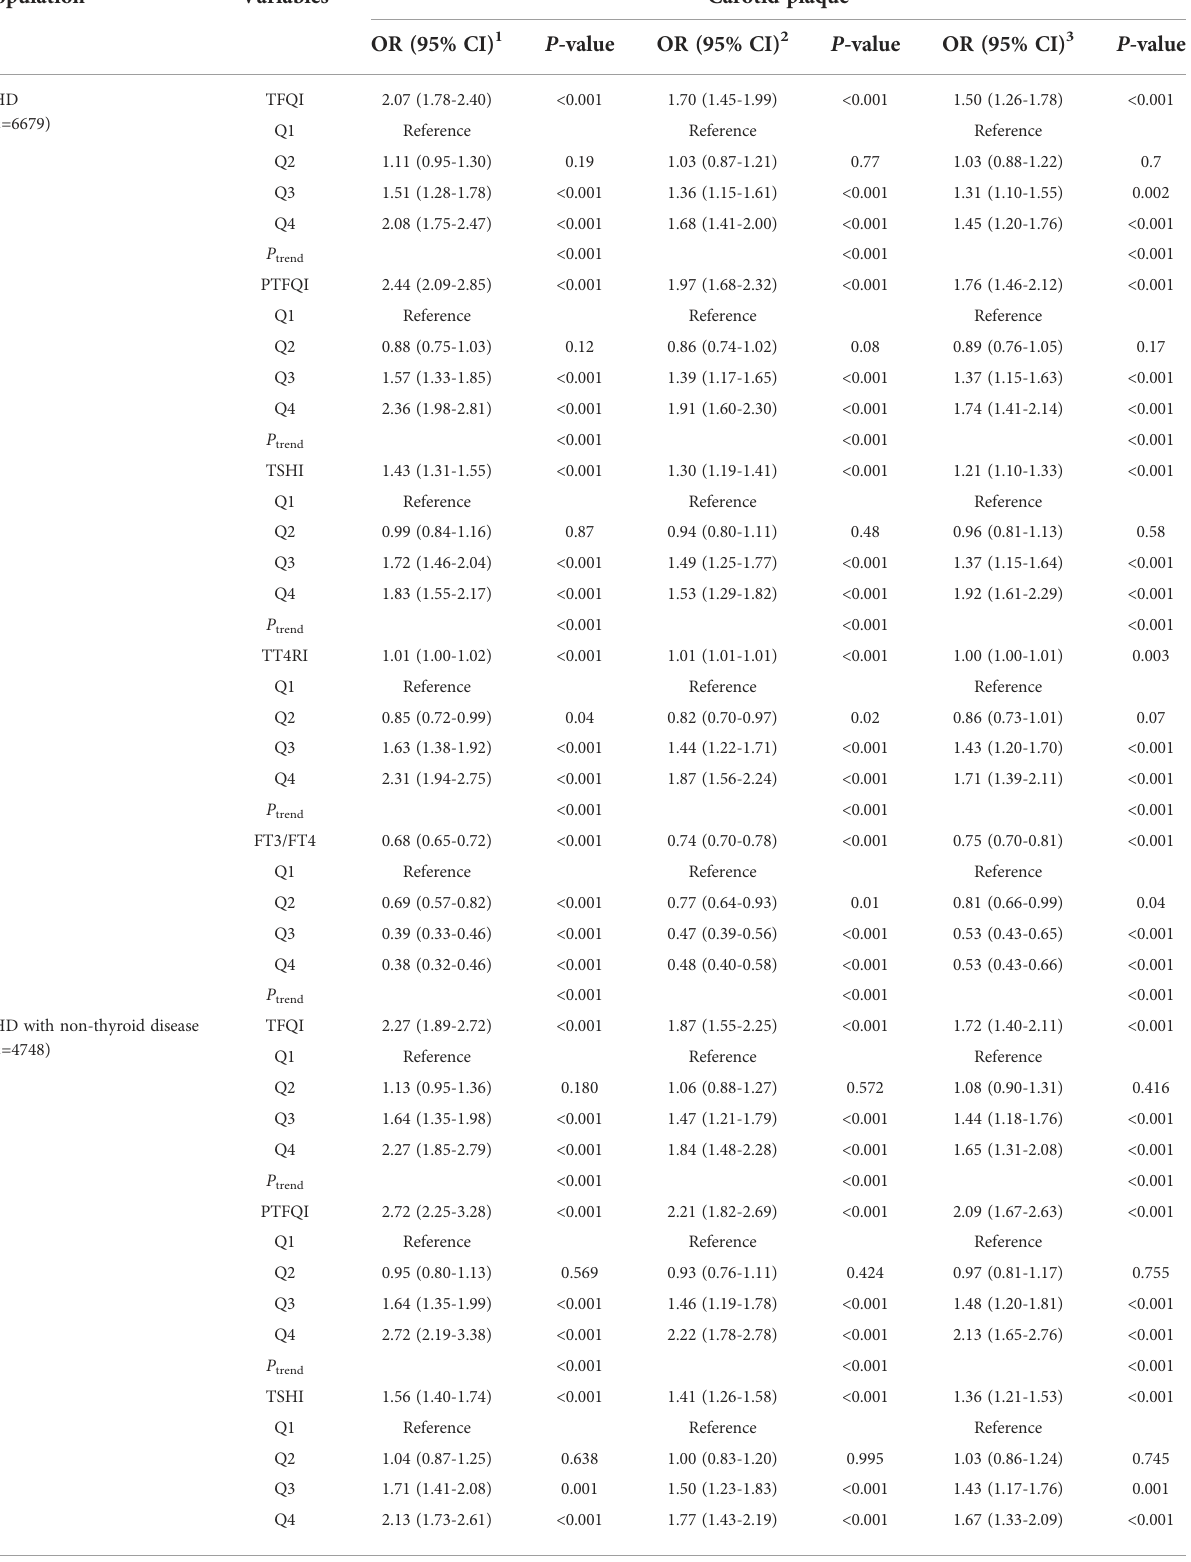
TABLE 2 Association between thyroid hormone sensitivity and carotid